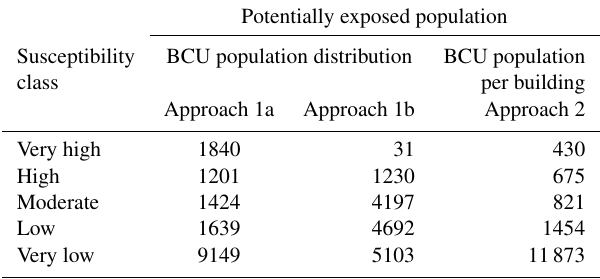
Figure 6. Potentially exposed population in Alenquer assigned to each building (approach